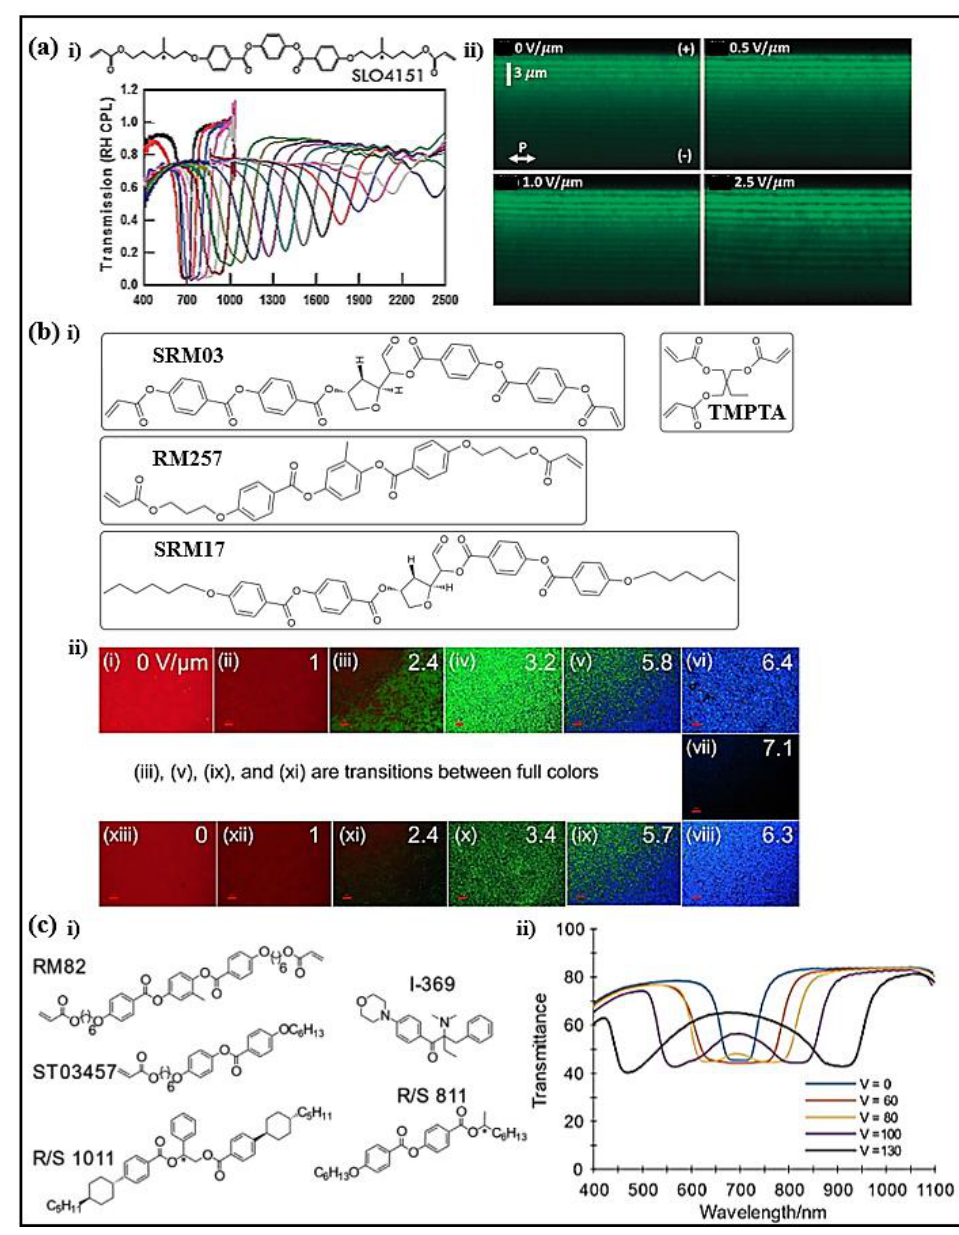
Figure 5. ( a ) Transmission spectra and cross-sectional images of the polymer-stabilized CLCs. Reproduced with permission from Ref. [78]. Copyright The Royal Society of Chemistry 2015. ( b ) i) Molecular structures of materials. ii) Electric-field-dependent reflection spectra. Reproduced with permission from Ref. [79]. NPG Asia Materials, 2020. ( c ) i) Chemical structures of materials. ii) Transmittance spectra for bandwidth splitting. Reproduced with permission from Ref. [80]. Copyright 2020 WILEY-VCH.